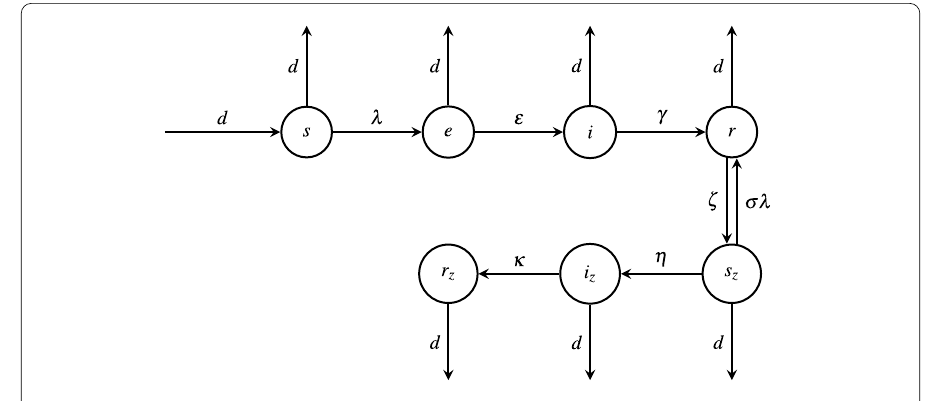
Figure 1 The compartmental system illustrating the VZV